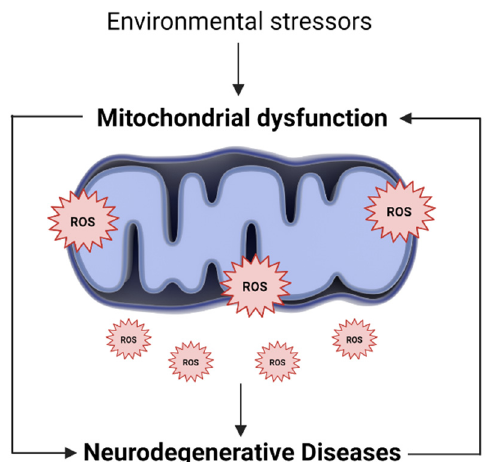
Figure 1. Oxidative stress and mitochondrial dysfunction loop. Along with endogenous sources, several environmental and exogenous stressors may lead to an excessive generation of mitochondrial ROS. The higher ROS levels, in turn, promote mitochondria injury, alter their metabolic enzymes and lead to its further dysfunction. In this way, mitochondrial oxidative stress can be the cause and consequence of mitochondrial dysfunction, being involved in the pathogenesis of several neurodegenerative diseases.